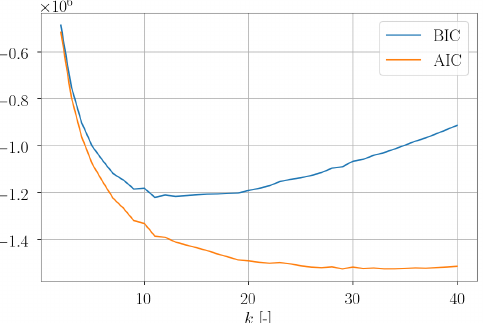
Figure 31. Akaike information criterion (AIC) and Bayesian information criterion (BIC) over k for setup